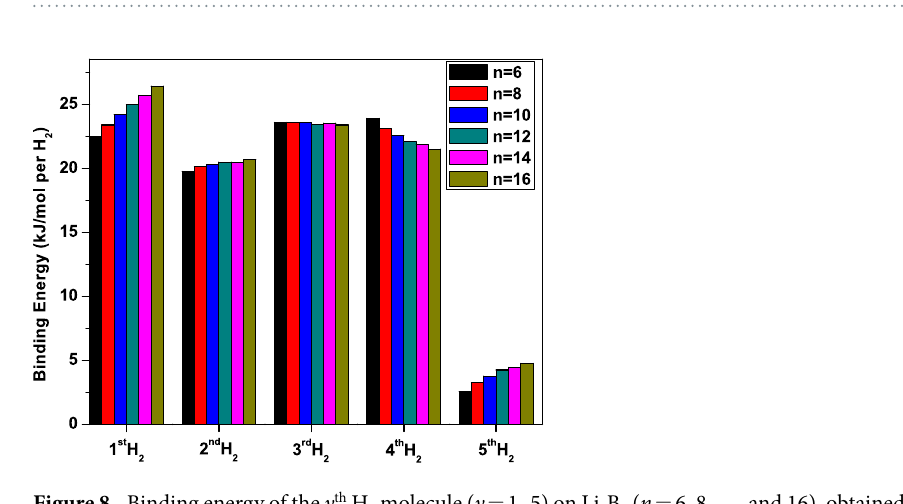
Figure 7. Average hydrogen binding energy on Li 2 B n ( n = 6, 8, … , and 16) with x H 2 molecules ( x = 1–5) adsorbed on each Li, obtained with TAO-BLYP-D.